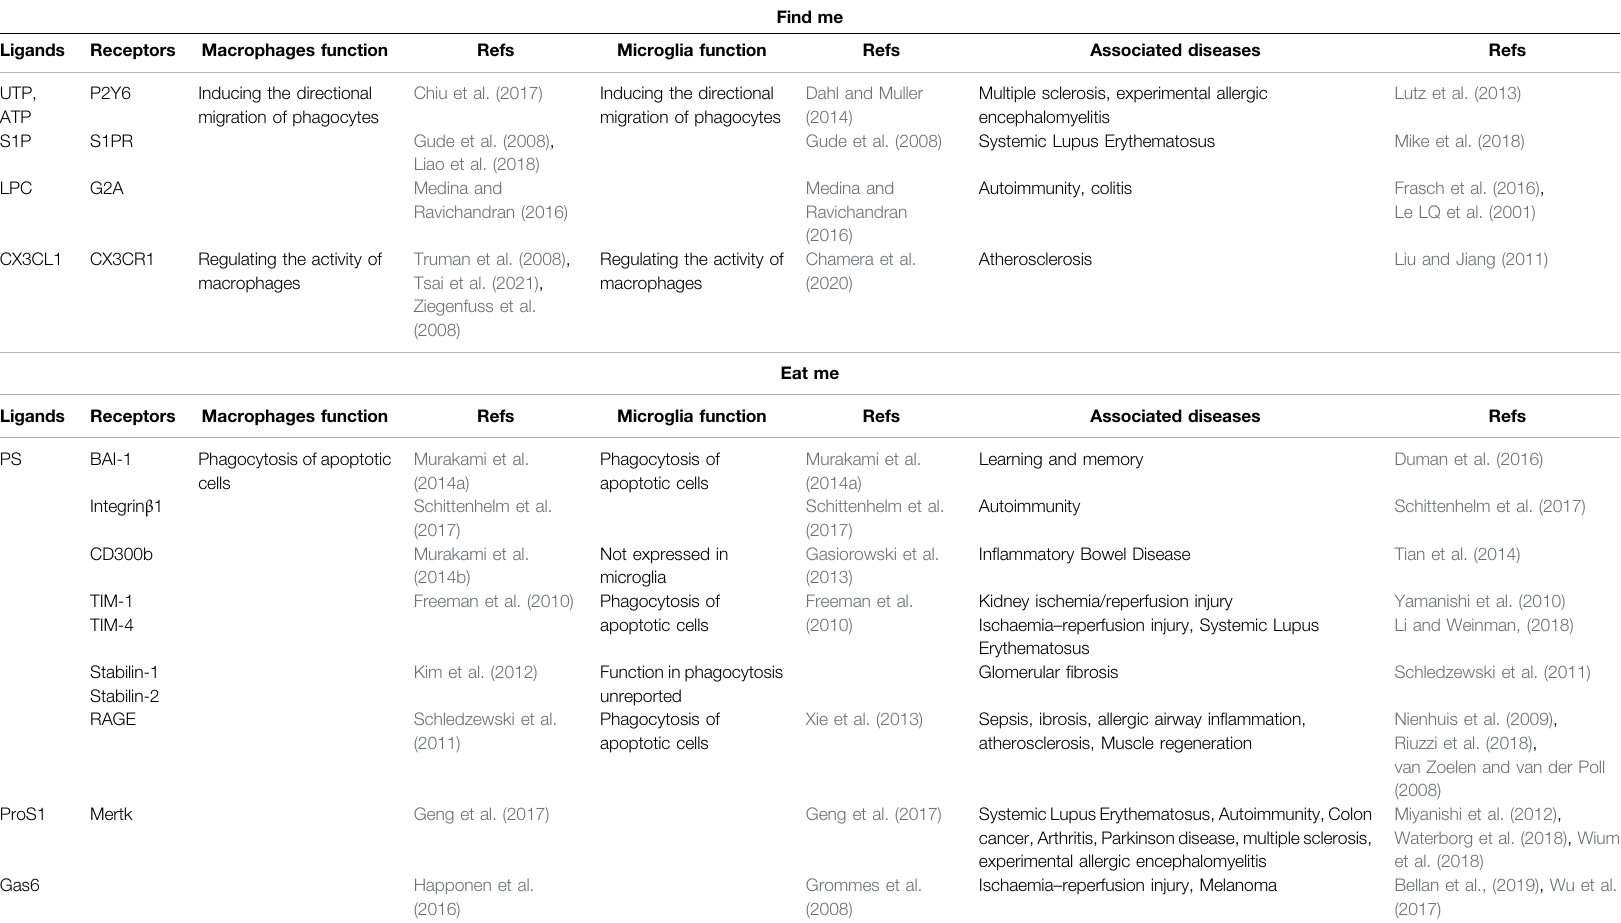
TABLE 1 | Some signaling molecules and receptors in the process of efferocytosis. “ fi nd me ” signals “ eat me ”